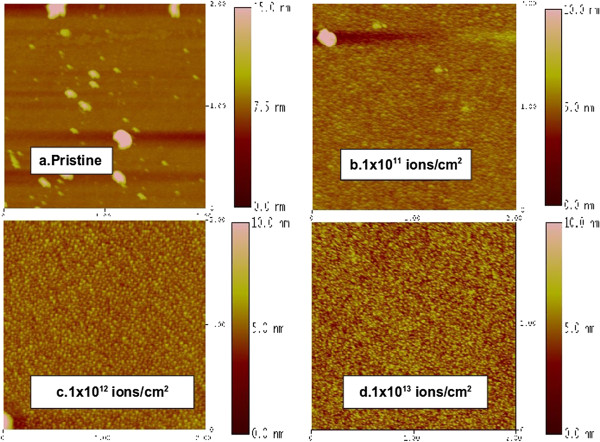
AFM images showing 2-μm scans of the topography of pristine and O7+-irradiated samples, with increasing fluence. (a) Pristine, (b) 1 × 1011 ions/cm2, (c) 1 × 1012 ions/cm2, and (d) 1 × 1013 ions/cm2.